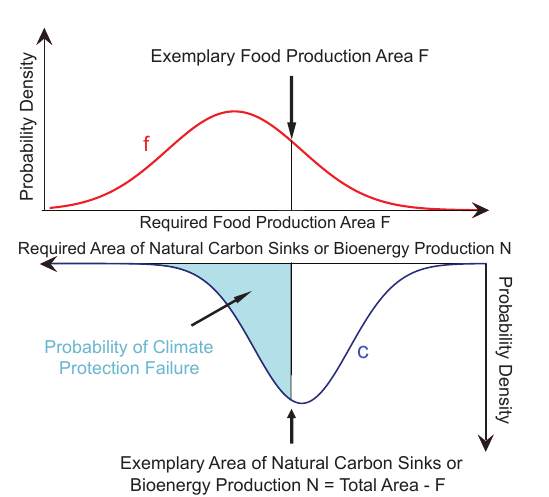
Figure 1. Concept of a probabilistic decision framework allowing for an evaluation agricultural management decisions under uncer- tainty of biophysical responses. Red PDF: uncertainty associated with the area of cropland required to fulfil future food demand. Blue PDF: uncertainty associated with the (natural) carbon sinks and stocks required to ensure climate